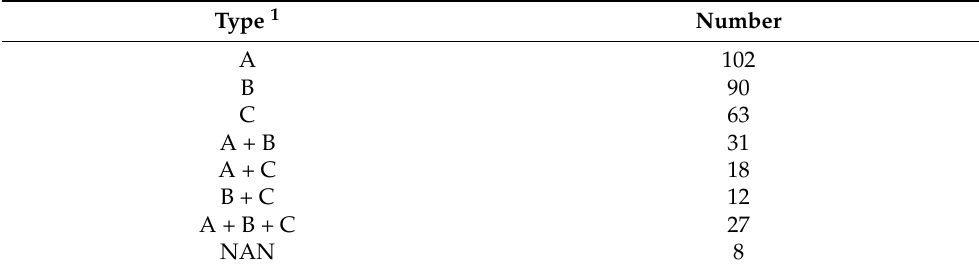
Table 1. The statistics chart of variation